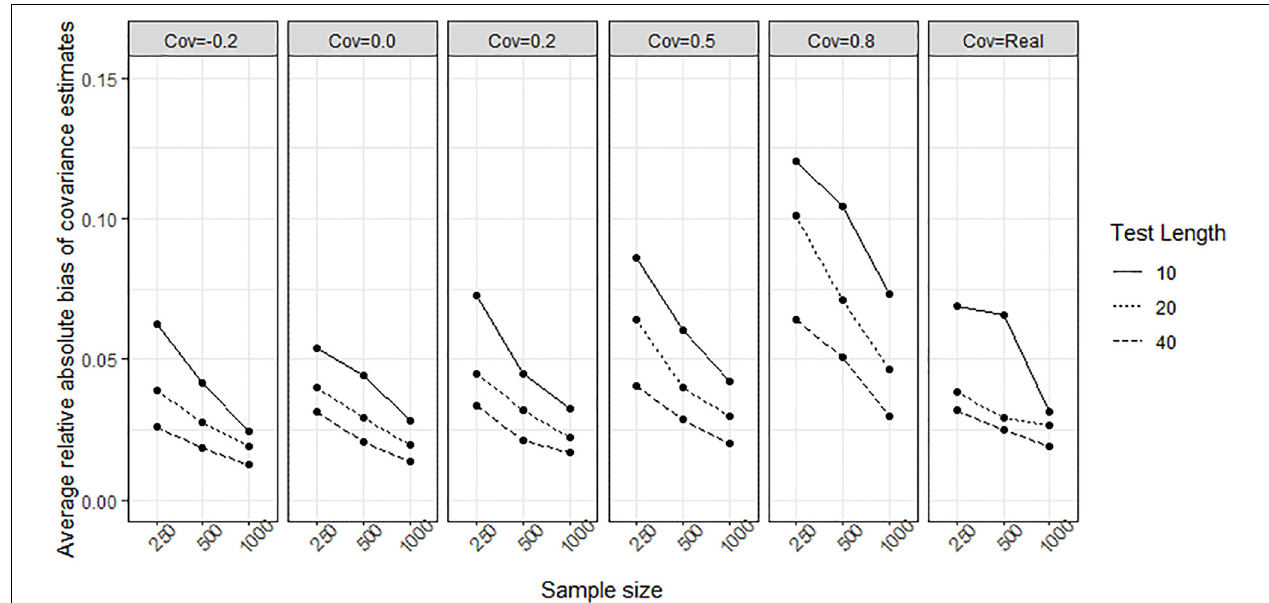
FIGURE 12 | Average relative absolute bias of variance-covariance estimation obtained by fitting the lognormal ipsative model to simulated data. Cov = the covariance between latent trait. Cov = Real indicates the variance-covariance matrix followed the empirical result in literature.